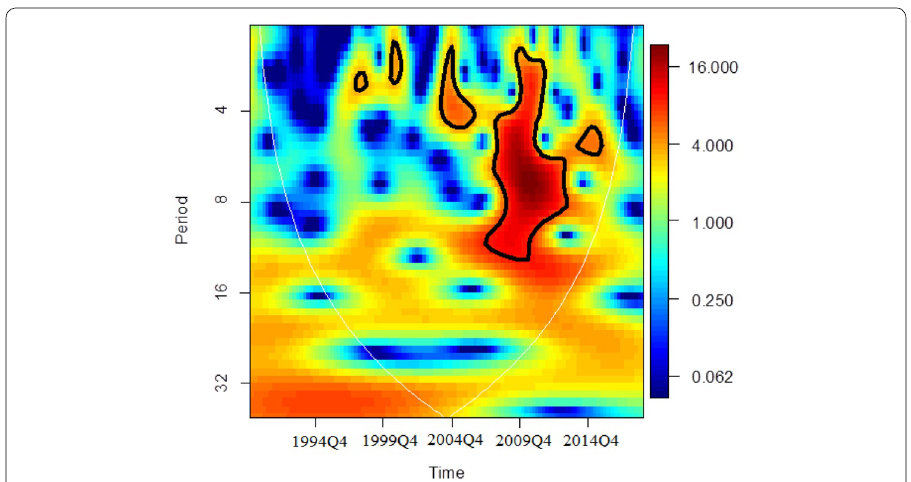
Fig. 2 Wavelet power spectrum for financial